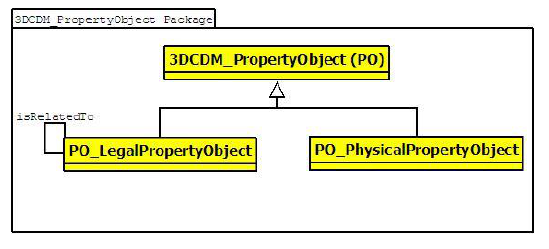
Figure 5. 3DCDM_PropertyObject (PO) package